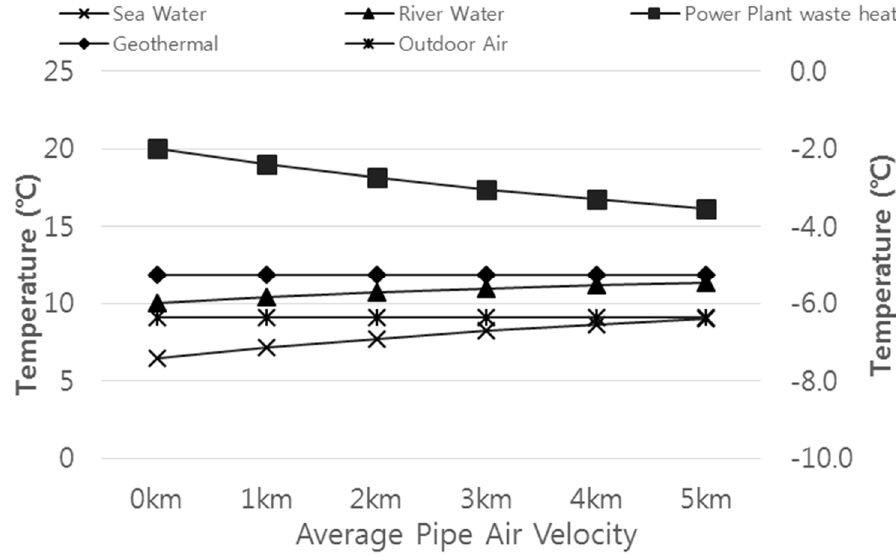
Figure 4. Average outlet temperature on the representative day of each heat source according to distance [7].